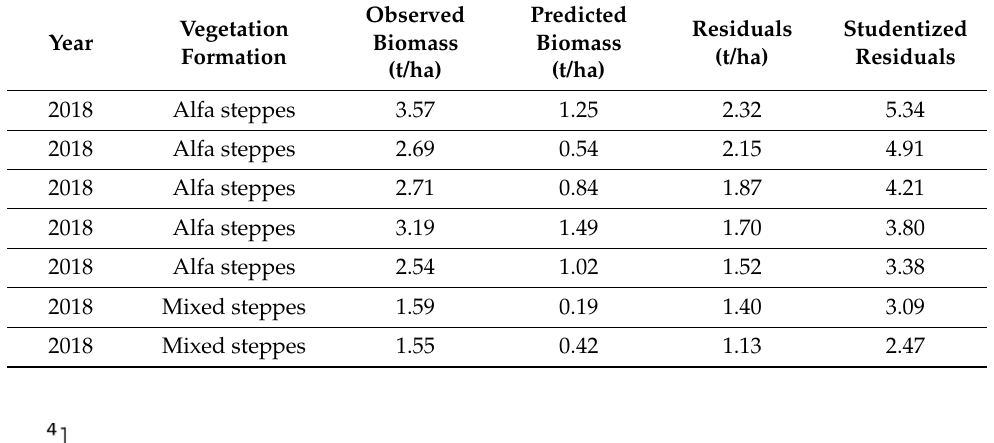
Table 7. Characteristics of the observations with highest values of studentized residuals (outside the [ − 2, 2] interval) for the prediction of rangeland biomass by linear regression (all observations pooled).